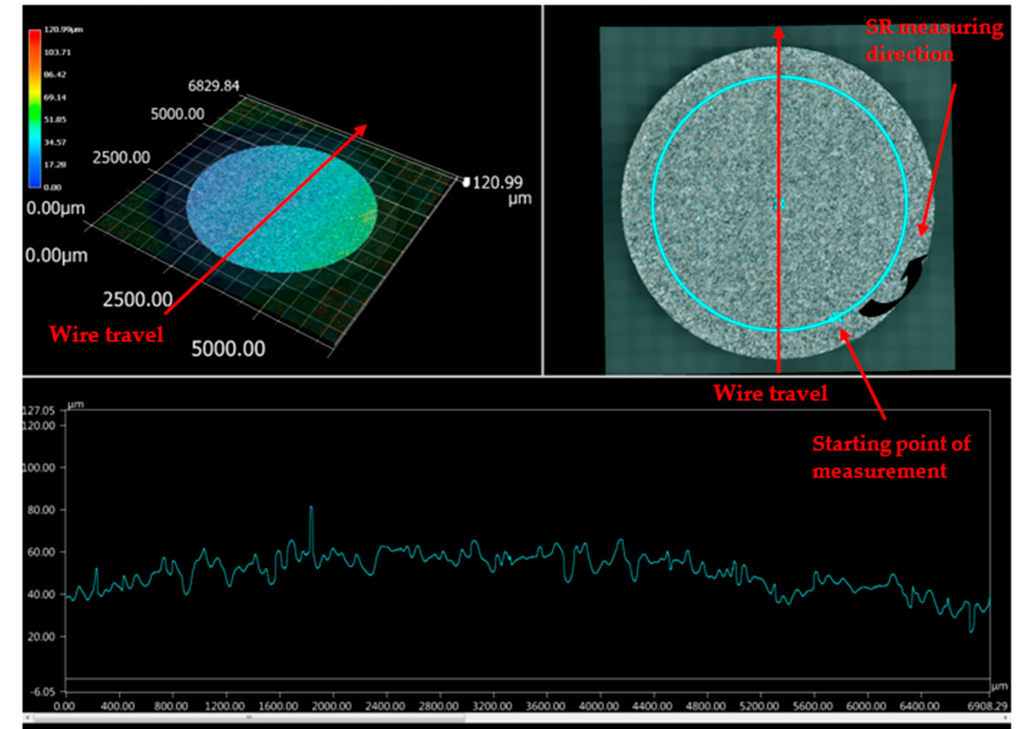
Figure 5. Surface analysis of machined sample at outermost periphery.